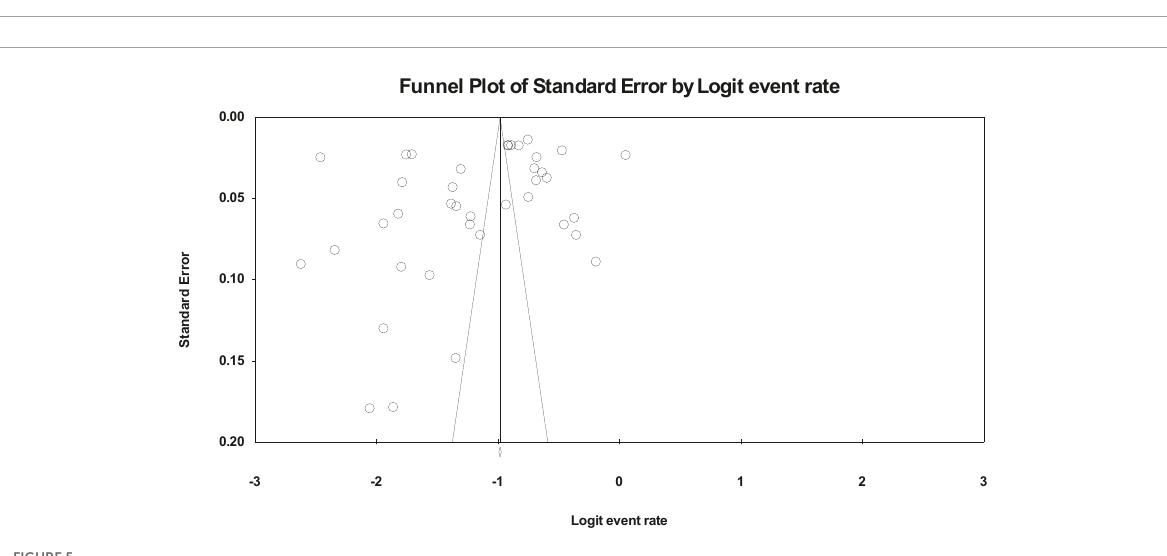
FIGURE5 Funnel plot of the 12-month aggregate prevalence of non-suicidal self-injury (NSSI) in